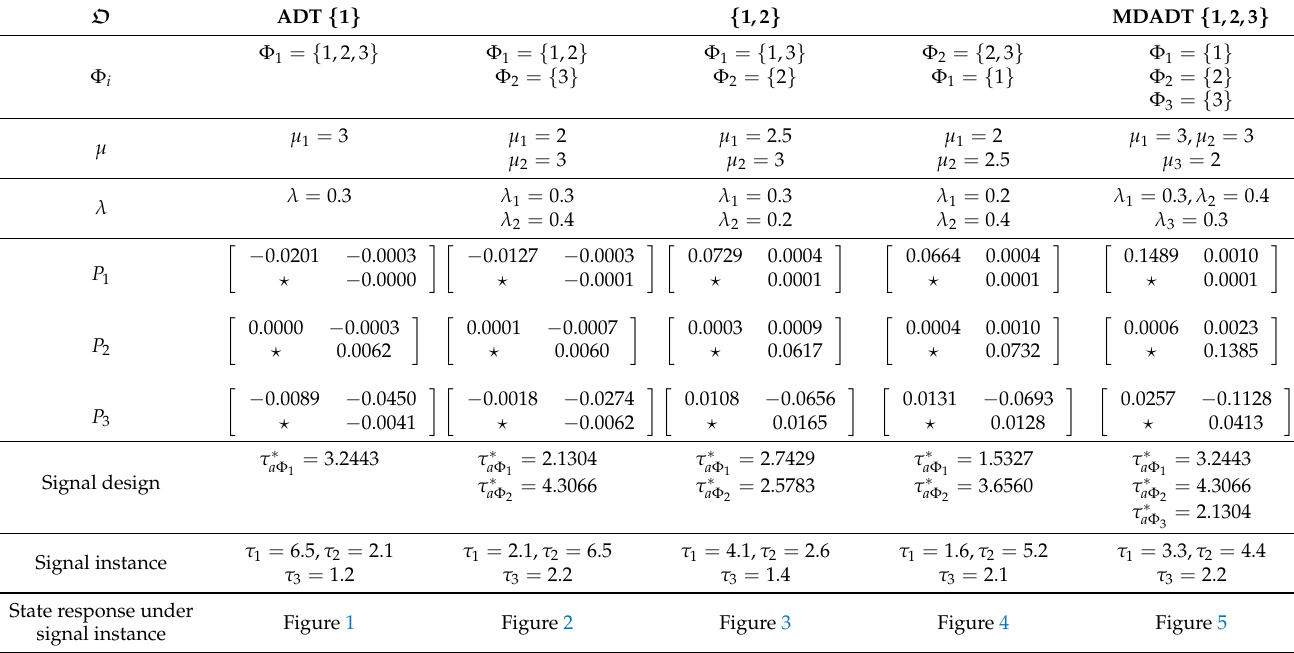
Table 1. Comparison of the results under three switching approaches ( x 0 = [ 0,0 ] T )